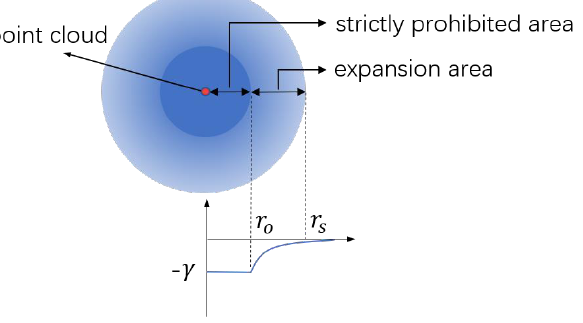
Figure 6. Expansion of an obstacle point cloud.